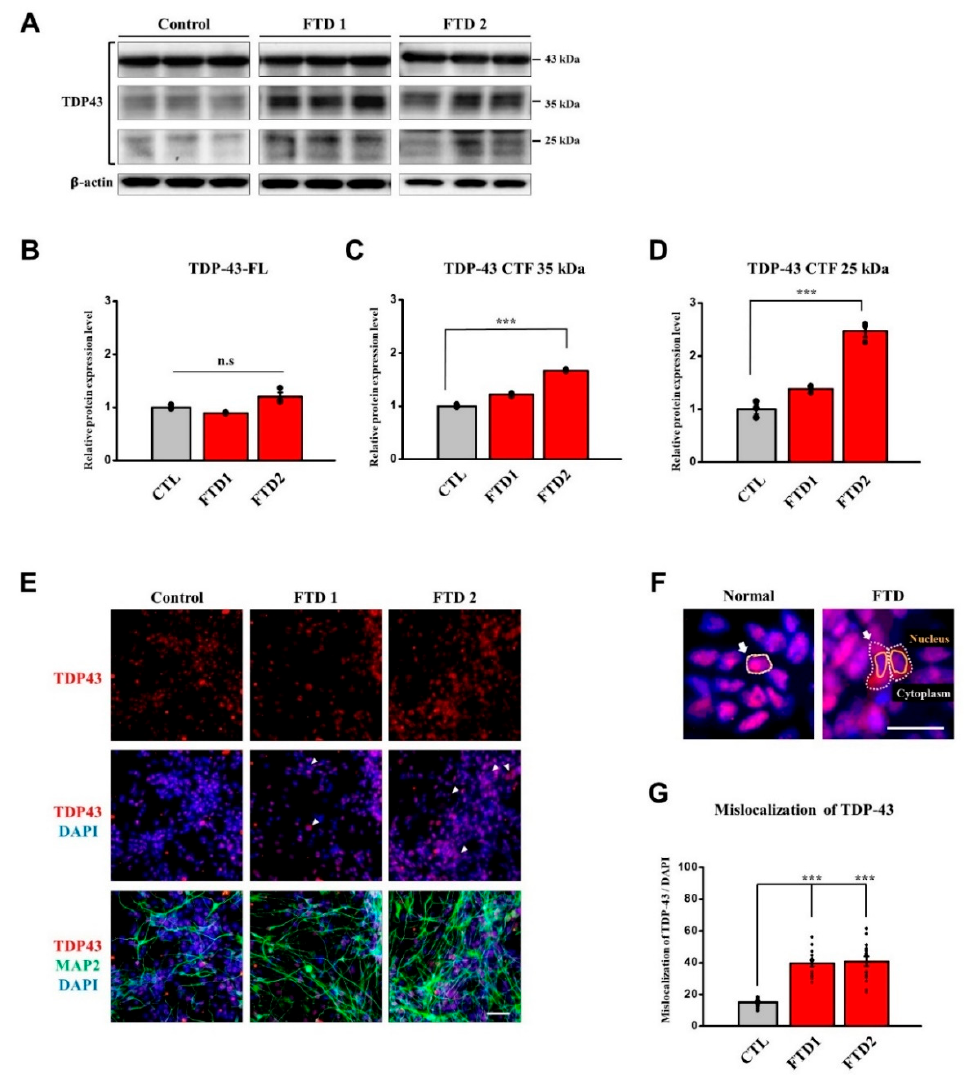
Figure 5. Abnormal expression patterns of TDP-43 protein in the bvFTD iPSC-derived neurons. ( A ) Immunoblot assay showing TDP-43 expression pattern full-length (FL): 43 kDa, fragments: 35 kDa, 25 kDa. β -actin was used as a loading control. Note that blot images indicated by dividing lines were chosen from di ff erent immunoblots due to the large size of samples. Protein quantifications were conducted under the same exposure time. Whole blot images are included in Supplementary Figure S4A–C. ( B ) Quantification of immunoblot assay showing the full length of TDP-43 protein expression. ( C ) Quantification of immunoblot assay showing the 35 kDa fragments of TDP-43 protein expression. ( D ) Quantification of immunoblot assay showing that 25 kDa fragments of TDP-43 protein expression levels were significantly increased in bvFTD2iPSC-derived neurons ( n = 3) (*: vs. normal control) * p < 0.05, ** p < 0.01, and *** p < 0.001, one-way ANOVA. ( E ) Immunocytochemical assay showing the expression of TDP-43 (red) and MAP2 (green), which were counter-stained with DAPI (blue), in the iPSC-derived neurons at three weeks of neuronal di ff erentiation. Scale bar = 50 µ m. ( F ) Simple description of mis-localized TDP-43 expression. Scale bar: 100 µ m. ( G ) Quantification of immunocytochemical assay using the translocation module in the MetaXpress ® 6 program. Note that mis-localized TDP-43 expression against the nucleus was increased in two bvFTD iPSC-derived neurons ( n = 16) (*: vs. normal control) * p < 0.05, ** p < 0.01, and *** p < 0.001, one-way